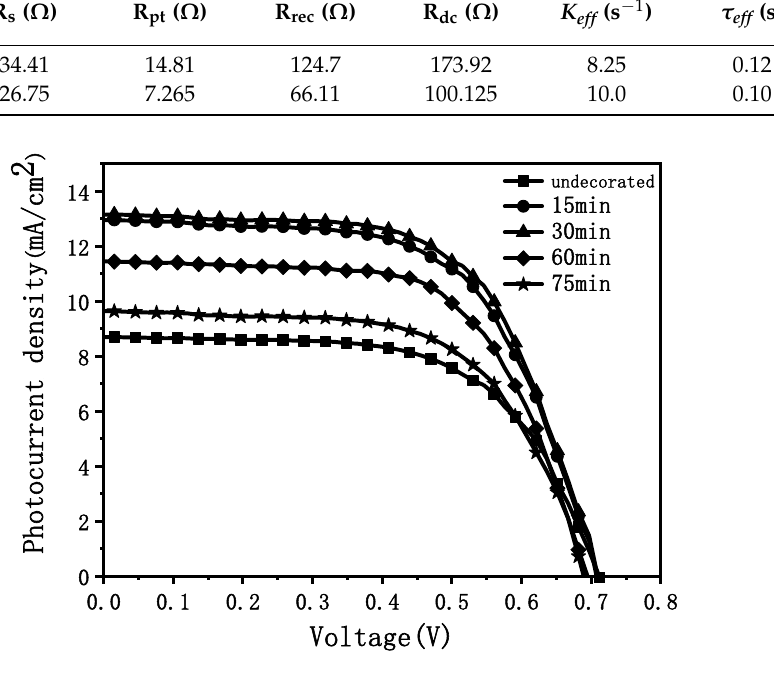
Figure 13. I–V curves of DSC after immersing anode film in 40 mM TiCl 4 aqueous solution at 70 ◦ C for different times. Table 3. Performance parameters of DSC assembled with anode thin film after soaking in 40 mM TiCl 4 aqueous solution at 70 ◦ C for different